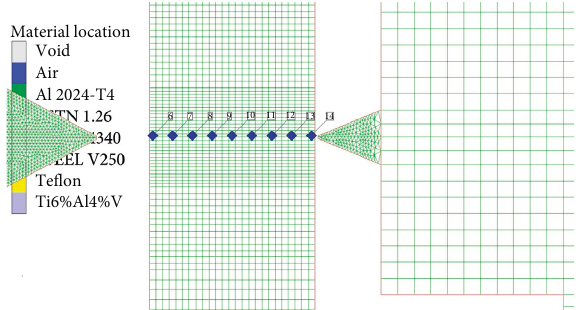
Figure 7: Selection of gauge points of the connecting